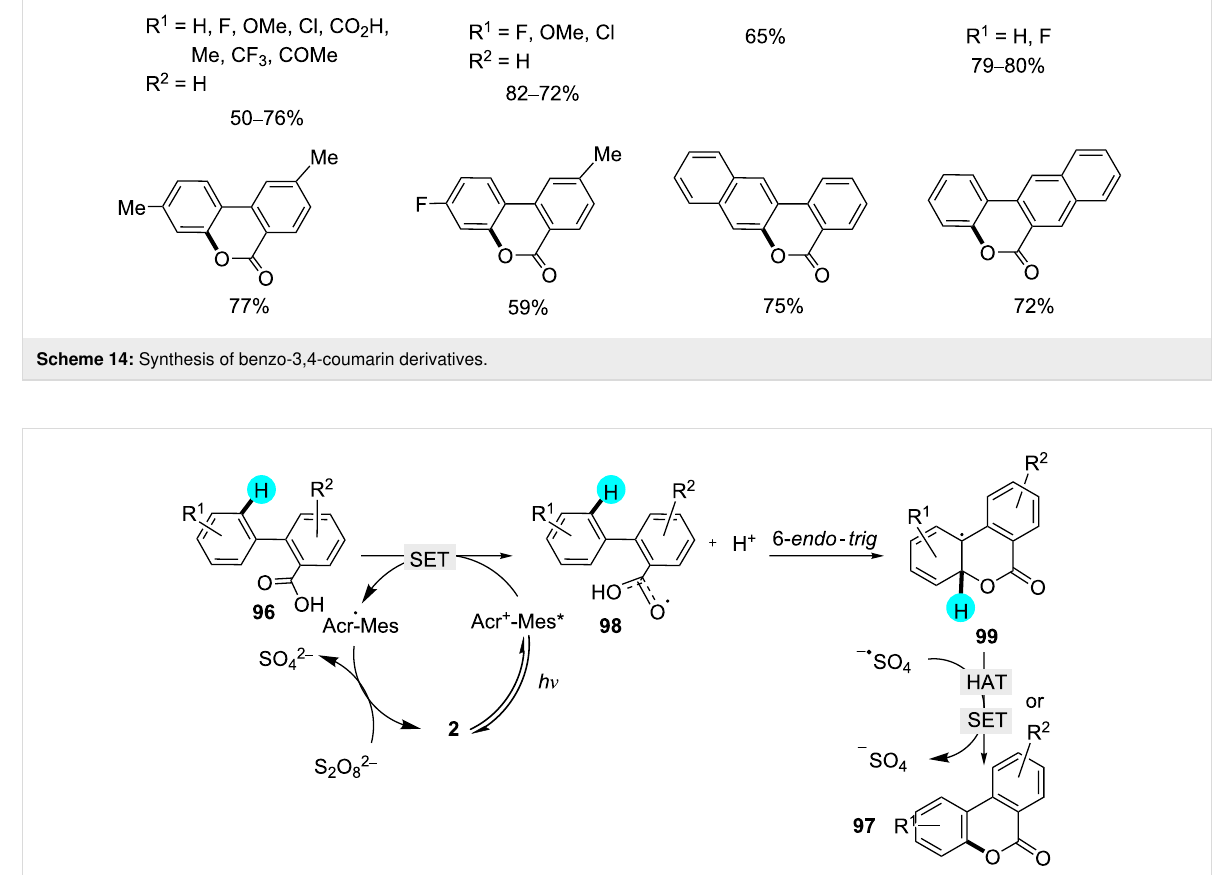
further oxidizes the aniline derivative 106 to generate the arene radical cation 108 . Then, the intermediate 109 is formed by de- protonation, which, upon reaction with a nitrate radical, gives the desired product 107